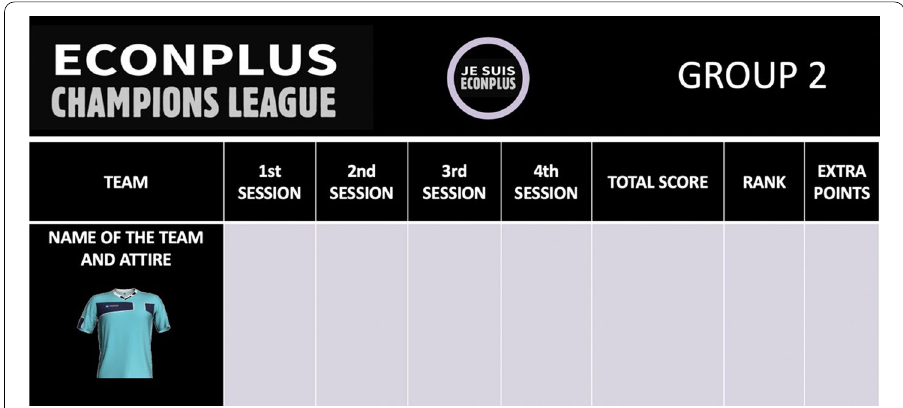
Fig. 5 Template of the leader board used in the group stage of the Econplus Champions